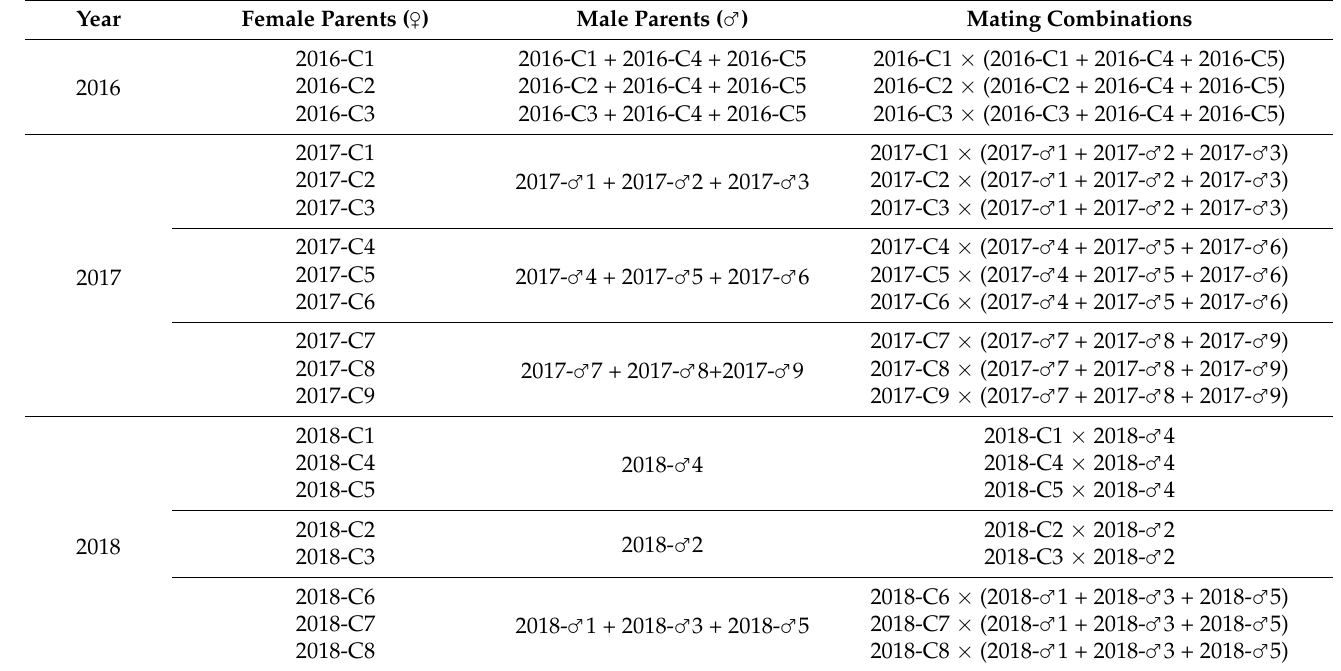
Table 1. Mating combinations of controlled pollination in each